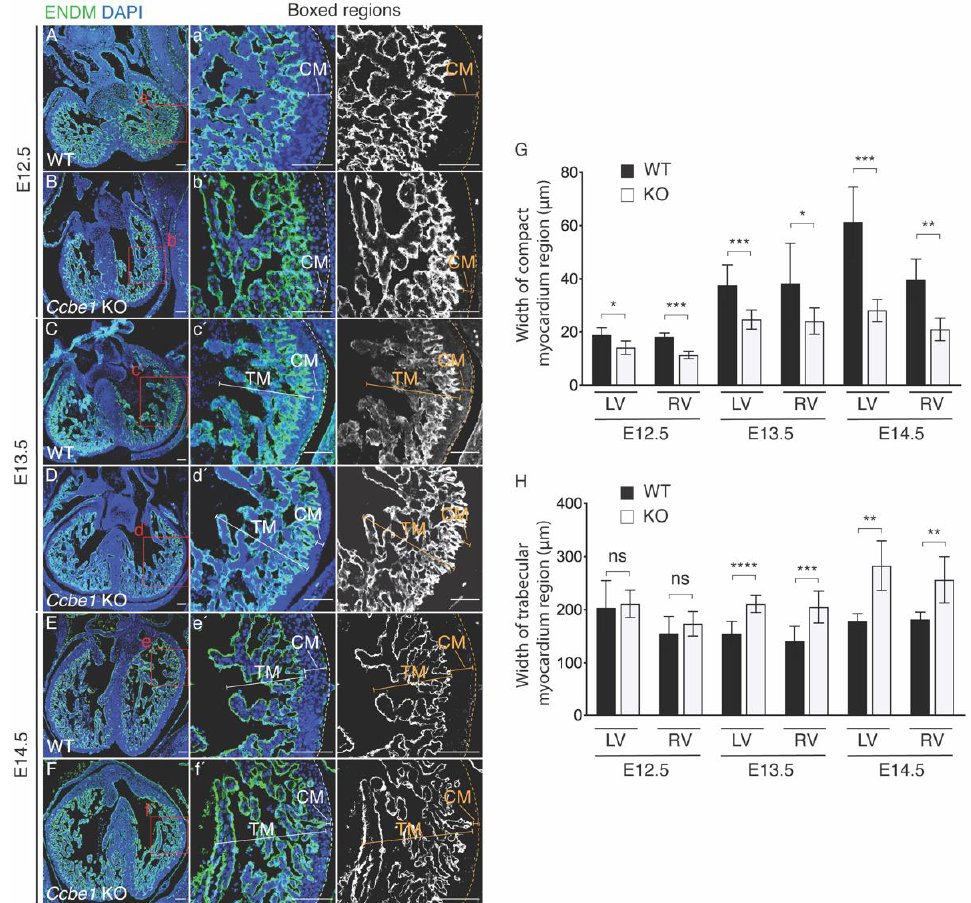
Figure 1. Ccbe1 tm1Lex mice display thinner right and left ventricle wall. ( A – F ) ENDM immunofluorescence in transverse sections of E12.5 ( A , B ), E13.5 ( C , D ), and E14.5 ( E , F ) hearts. Images are representative of the following number of replicates: wild-type, n = 4; mutant, n = 5 at E12.5; wild-type, n = 7; mutant, n = 8 at E13.5; wild-type, n = 5; mutant, n = 5 at E14.5. ( a ′ – f ′ ) are magnification of the LV region indicated by the boxed areas in panels ( A – F ), respectively. ( G ) Compact myocardium is thinner in right and left ventricle of Ccbe1 mutant hearts at E12.5, E13.5 and E14.5 stages. ( H ) Trabecular myocardium thickness is increased in the left and right ventricles in Ccbe1 mutant hearts at E13.5 and E14.5 stages. ns, nonsignificant; * p < 0.05; ** p < 0.01; *** p < 0.001; **** p < 0.0001. Differences were considered statistically significant when p < 0.05. Error bars represent SDs. Scale bars = 100 μm. RV, right ventricle; LV, left ventricle.